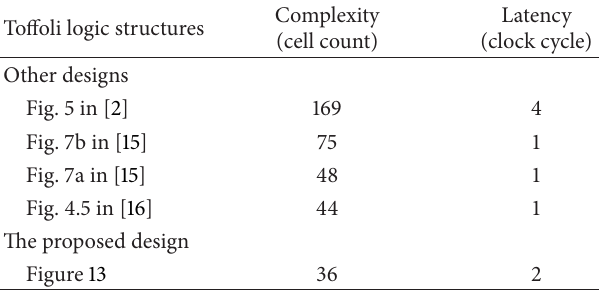
Table 3: Comparison between the proposed QCA design for the Toffoli gate and other designs.